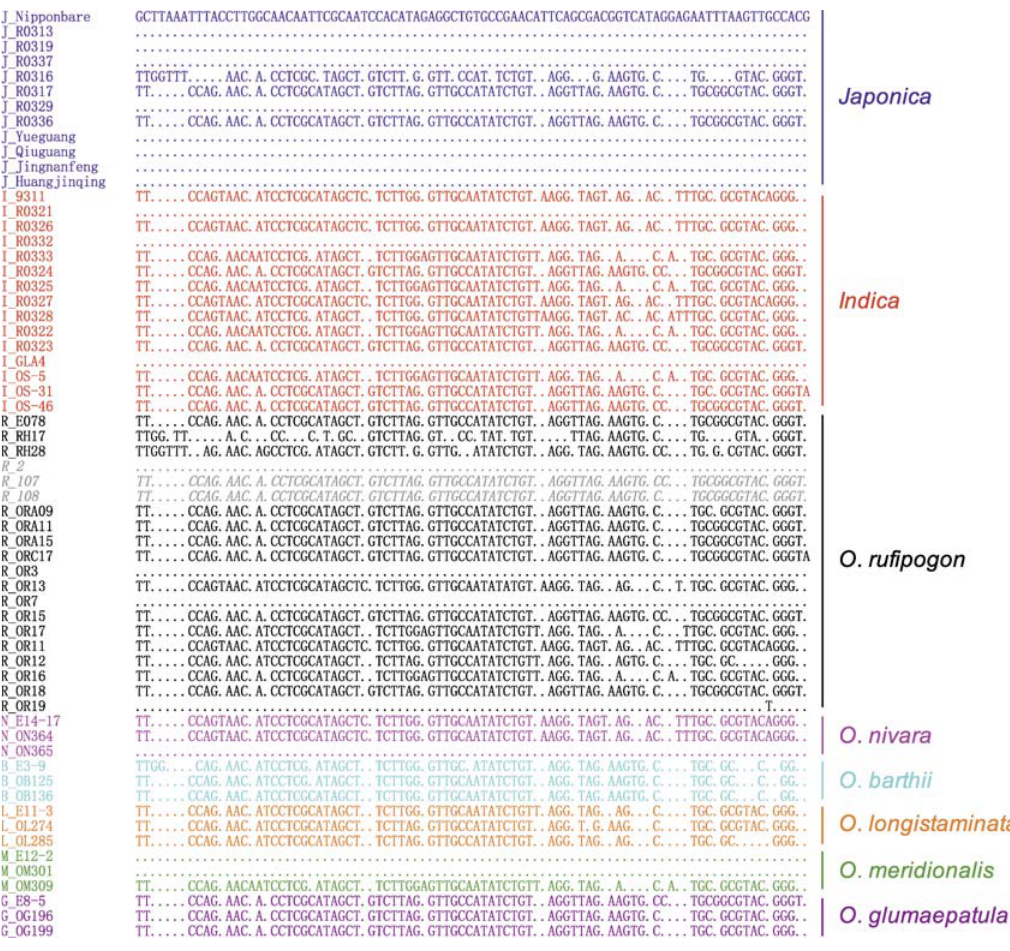
Figure 4. An Example of Haplotypes from a High Polymorphism Gene AK069589 Haplotypes were identified by the polymorphic sites in O. sativa. There are two distinct haplotypes that differ from each other by nearly 100 substitutions. Both subspecies of cultivars and the three wild species, O. rufipogon, O. nivara, and O. meridionalis, carry both haplotypes. The two haplotypes also coexist in the same population of O. rufipogon from Jiangxi, China, the three specimens of which are indicated in gray.